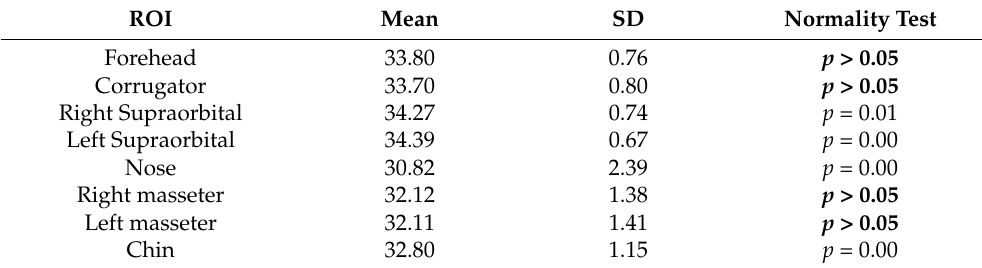
Table 2. Thermal database averages.